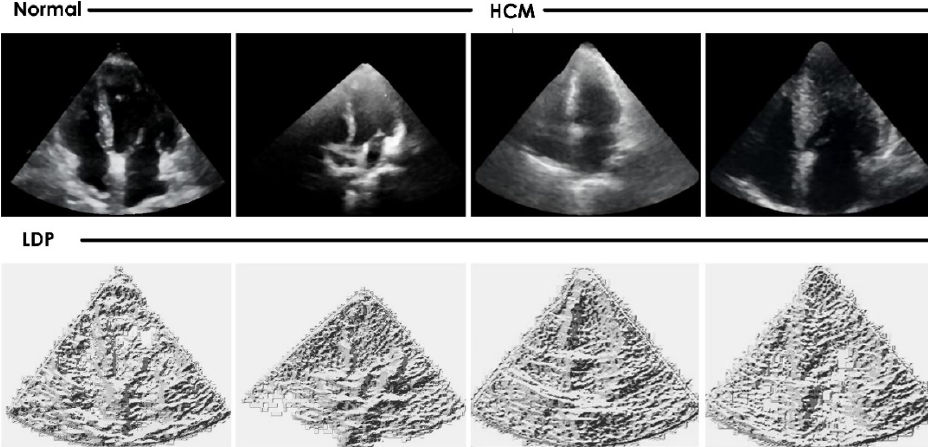
Figure 6. Preprocessed 4-chamber heart images and the corresponding LDP images.